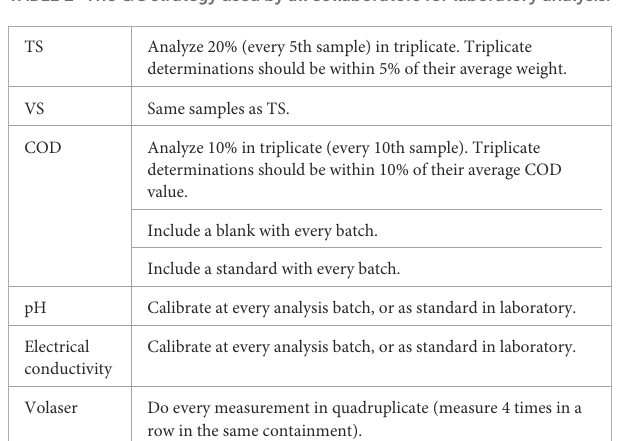
TABLE 2 The QC strategy used by all collaborators for laboratory